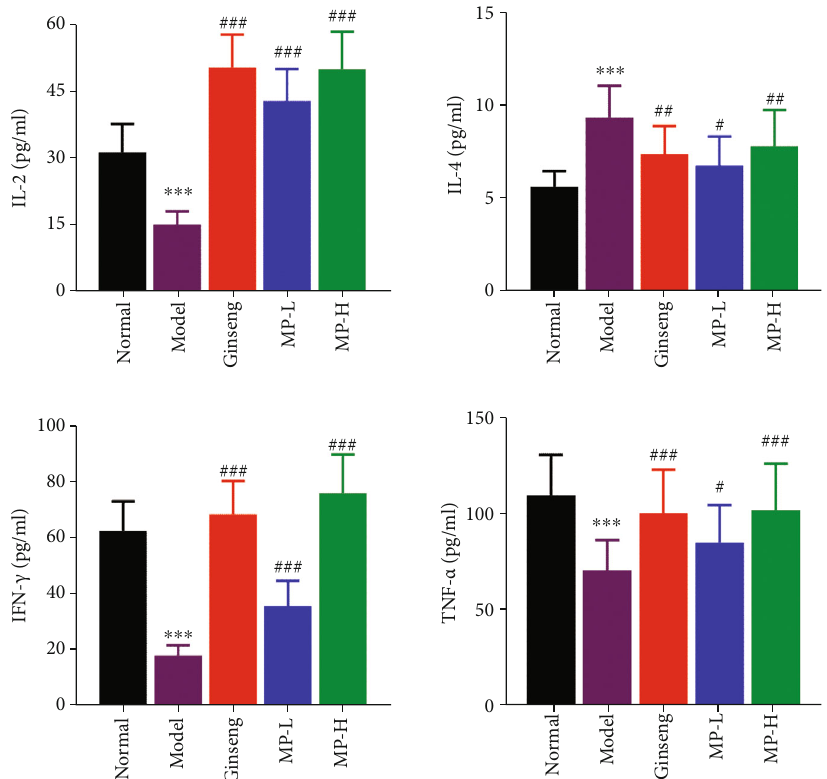
Figure 8: E ff ects of Maca polysaccharides on serum cytokines of IFN- γ , TNF- α , IL-2, and IL-4 ( n = 12 ); ∗∗∗ p < 0 : 001 vs. control group; # p < 0 : 05 , ## p < 0 : 01 , and ### p < 0 : 001 vs. model